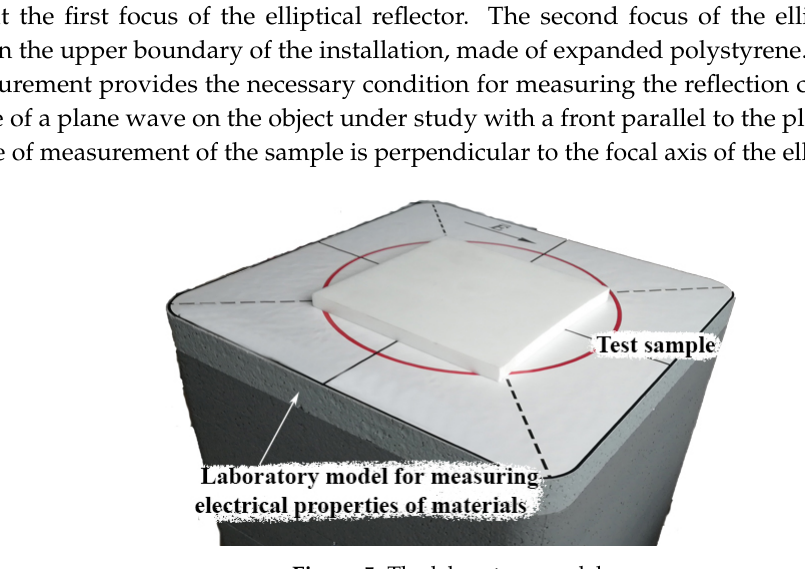
Figure 5. The laboratory